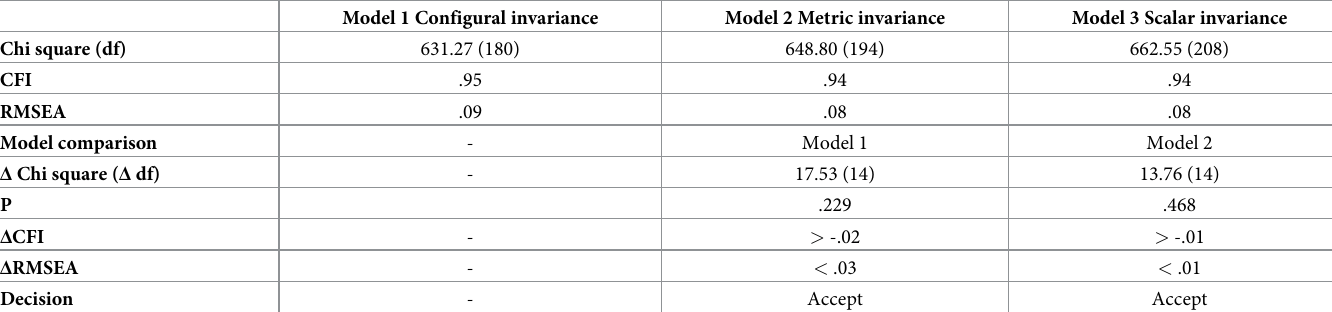
Table 8. Analyses of measurement invariance of the BSS scale across